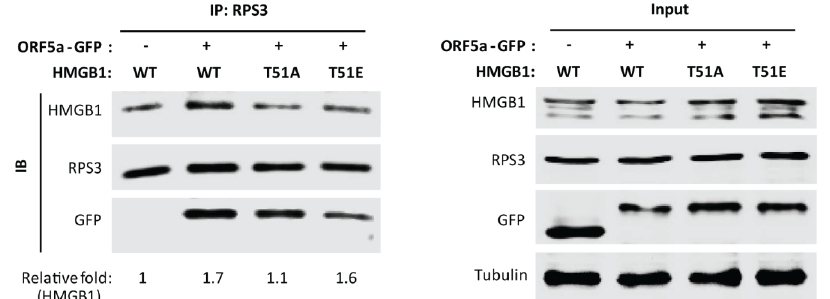
Figure 6 . Phosphorylation of HMGB1 at Thr-51 residue is important for HMGB1 binding with RPS3. HEK293T cells were co-transfected with HMGB1 WT, T51A, or T51E plasmid and GFP or PRRSV ORF5a-GFP plasmid. At 30 h post-transfection, the cells were harvested for IP with RPS3 antibody, followed by IB. Relative levels of HMGB1 are shown as folds below the images after normalization with RPS3 in densitometry analysis. The inputs were also included in IB.